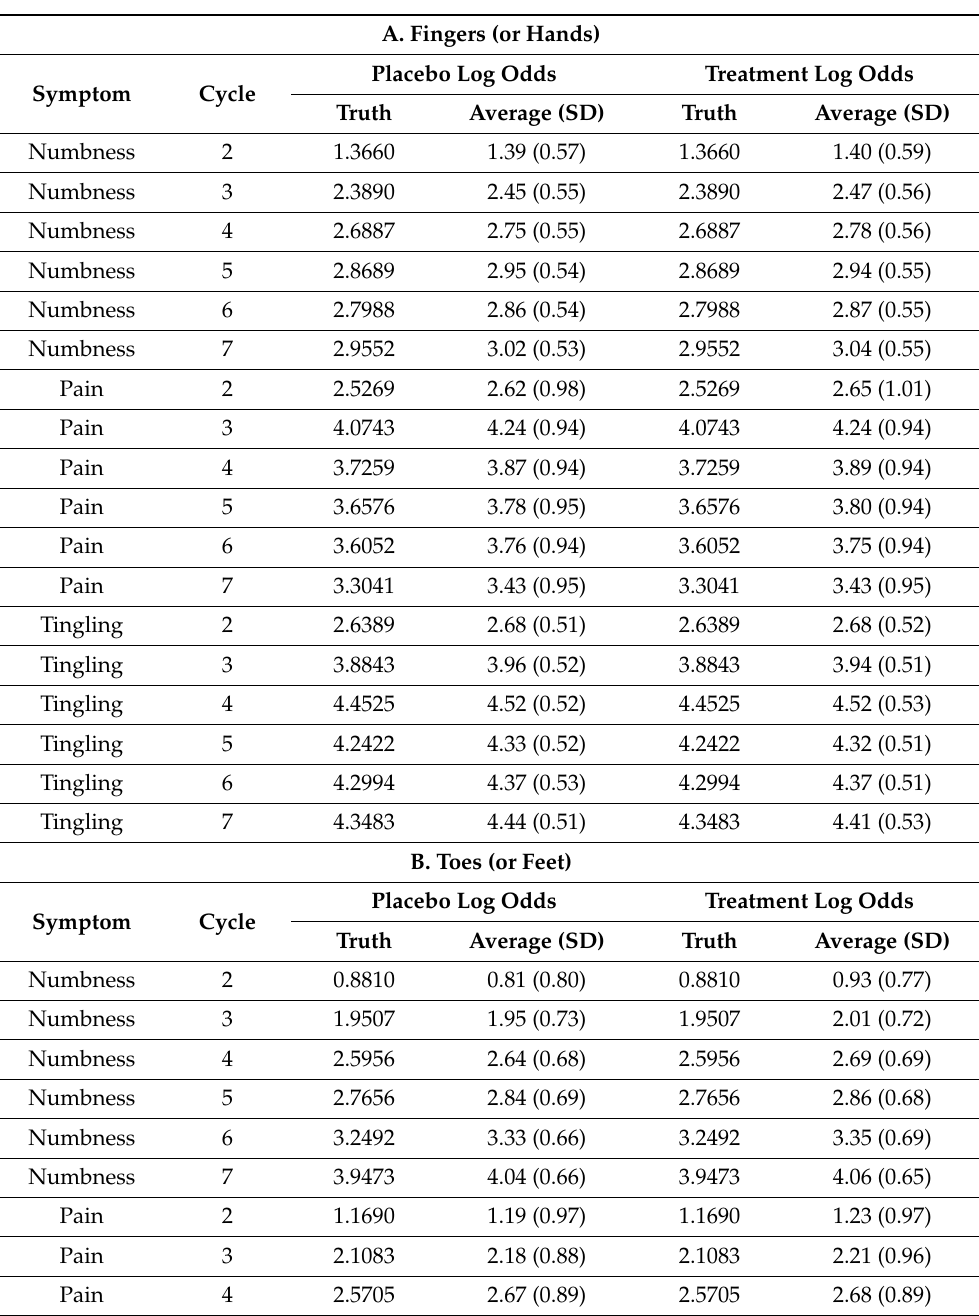
Table 2. Design application. Scenario 1: For each log odds (compared with cycle 1, baseline), we report the average estimate over the 1000 datasets generated as a measure of the true estimate and the corresponding standard deviation (SD) or empirical standard error. The “true” estimates of the log odds compared with cycle 1 (baseline) for the placebo arm were based on the analysis of the pooled placebo arms from two recently completed OIPN prevention trials (NCCTG N08CB; MC11C4). The “true” estimates of the log odds compared with cycle 1 (baseline) assumed for the treatment arm were hypothesized as being the same as the placebo arm (i.e., responses over time coincide). Note that cycle 1 served as a baseline (prior to oxaliplatin exposure), while patient-reported responses measured at each two-week cycle (2–6), as well as at 2 weeks post-cycle 6 (day 1 of cycle 7, prior to oxaliplatin treatment), served as the post-baseline